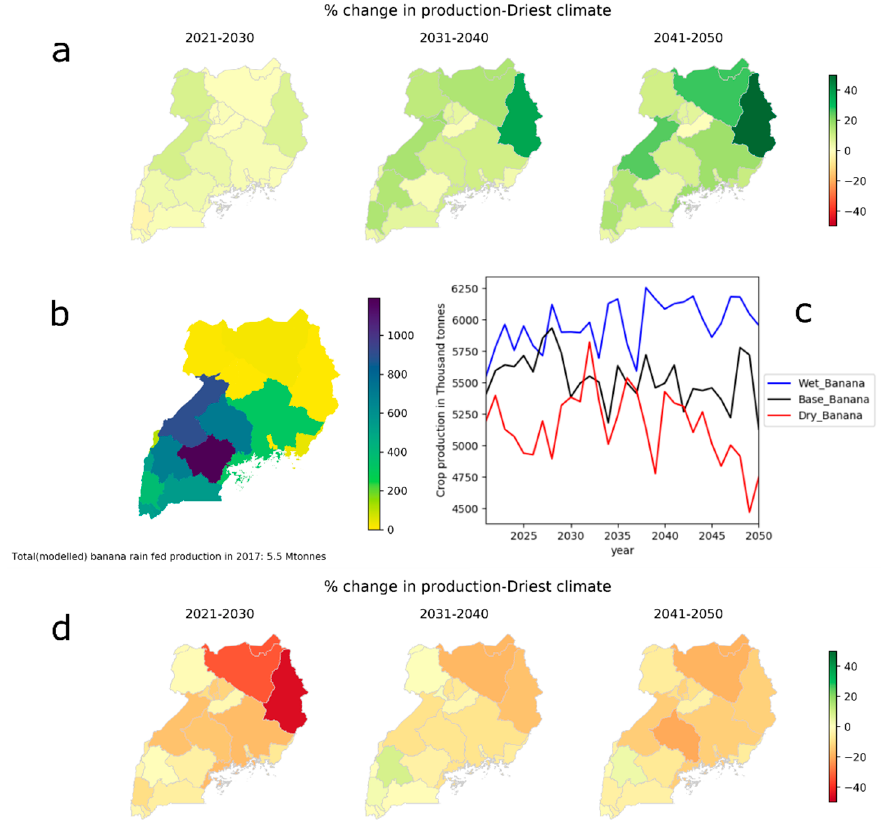
Figure 7. Climatic impact on banana (plantains) production. Catchment specific di ff erences in crop production in the ( a ) wettest and ( d ) driest climate futures and the reference scenario is presented. Total modelled (catchment specific) banana production ( b ) in 2017 is provided to di ff erentiate high production zones from the rest. Parts ( a ) and ( d ) should always be interpreted in relation with part b . The line graph ( c ) provides the annual variation in banana production between the analyzed climate futures on a national level.